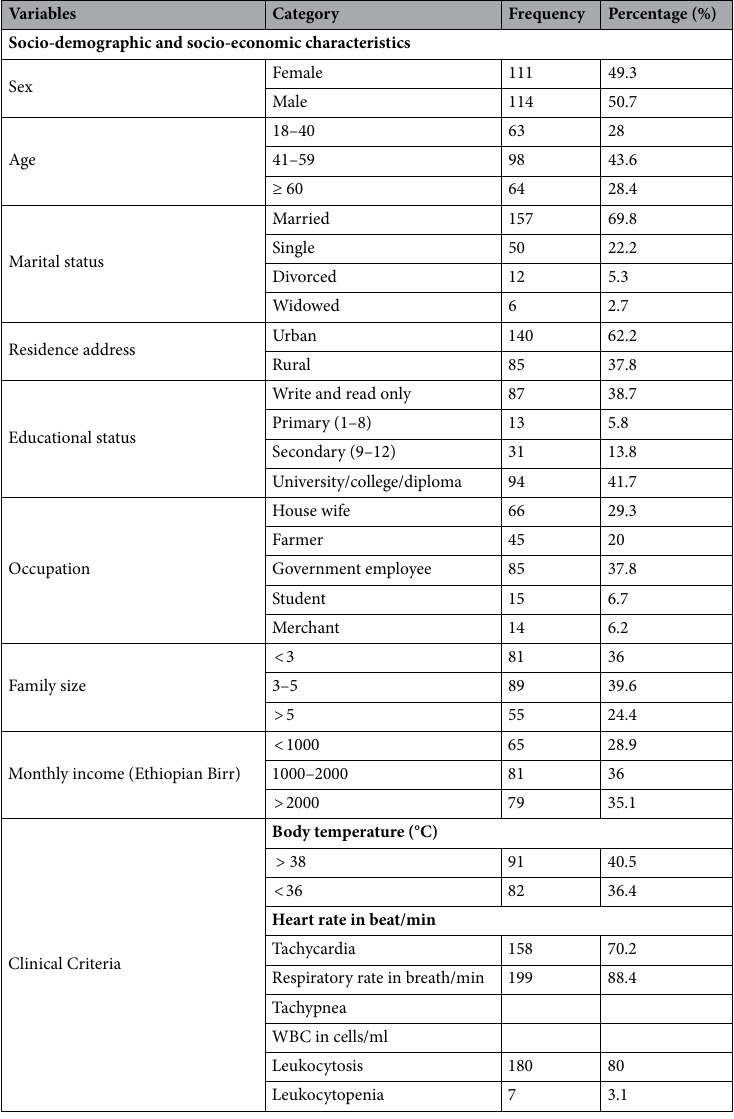
Table 1. Socio-demographic, socio-economic and clinical characteristics among BSI suspected patients (n = 225) at AMGH, southern Ethiopia, 2020. BSI: Bloodstream infections, AMGH: Arba Minch General Hospital, WBC: White blood cell, ml: